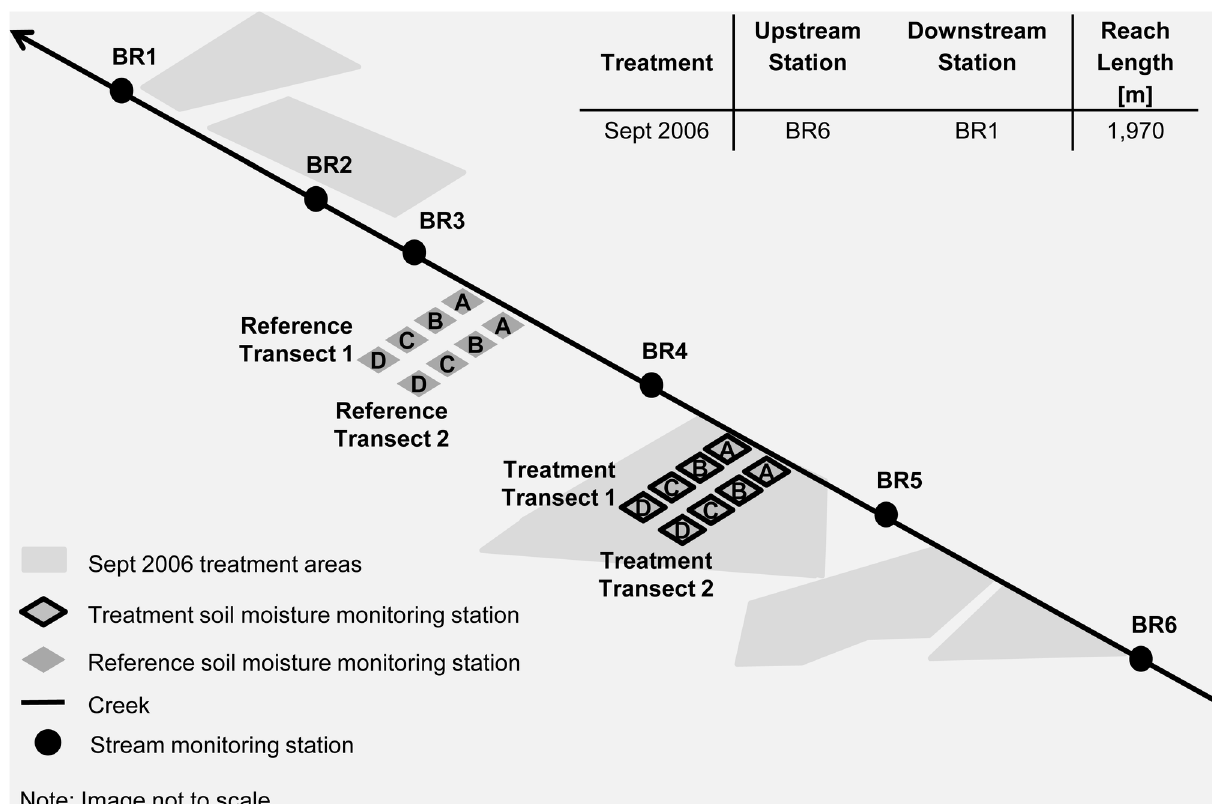
Figure 3. Illustration of Bailey Project treatment areas and stream and soil monitoring station